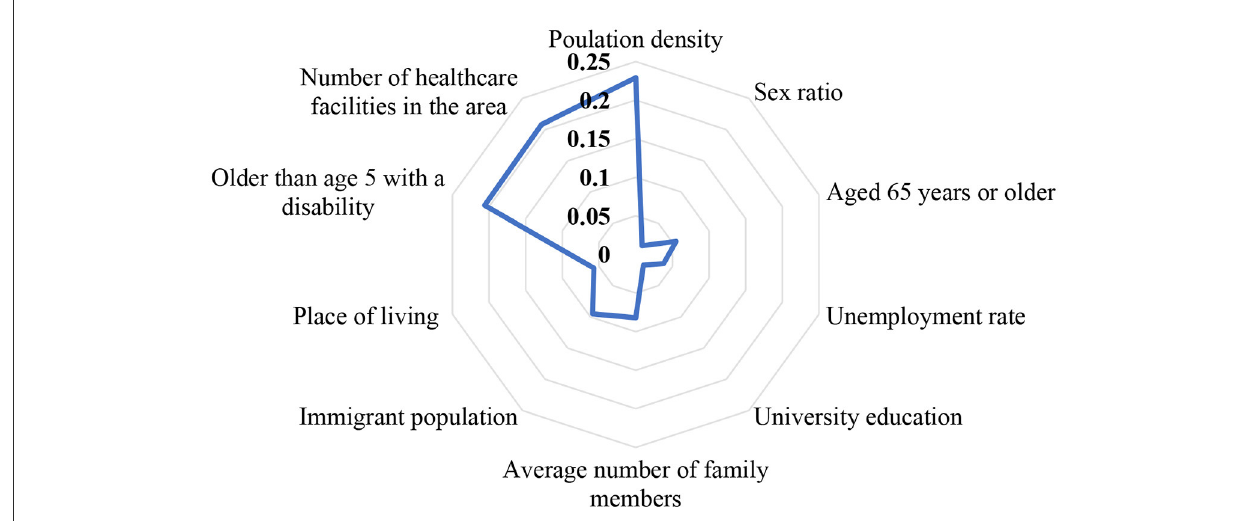
FIGURE1 Radiated diagram of social vulnerability indicators in the COVID-19 pandemic in Iran.